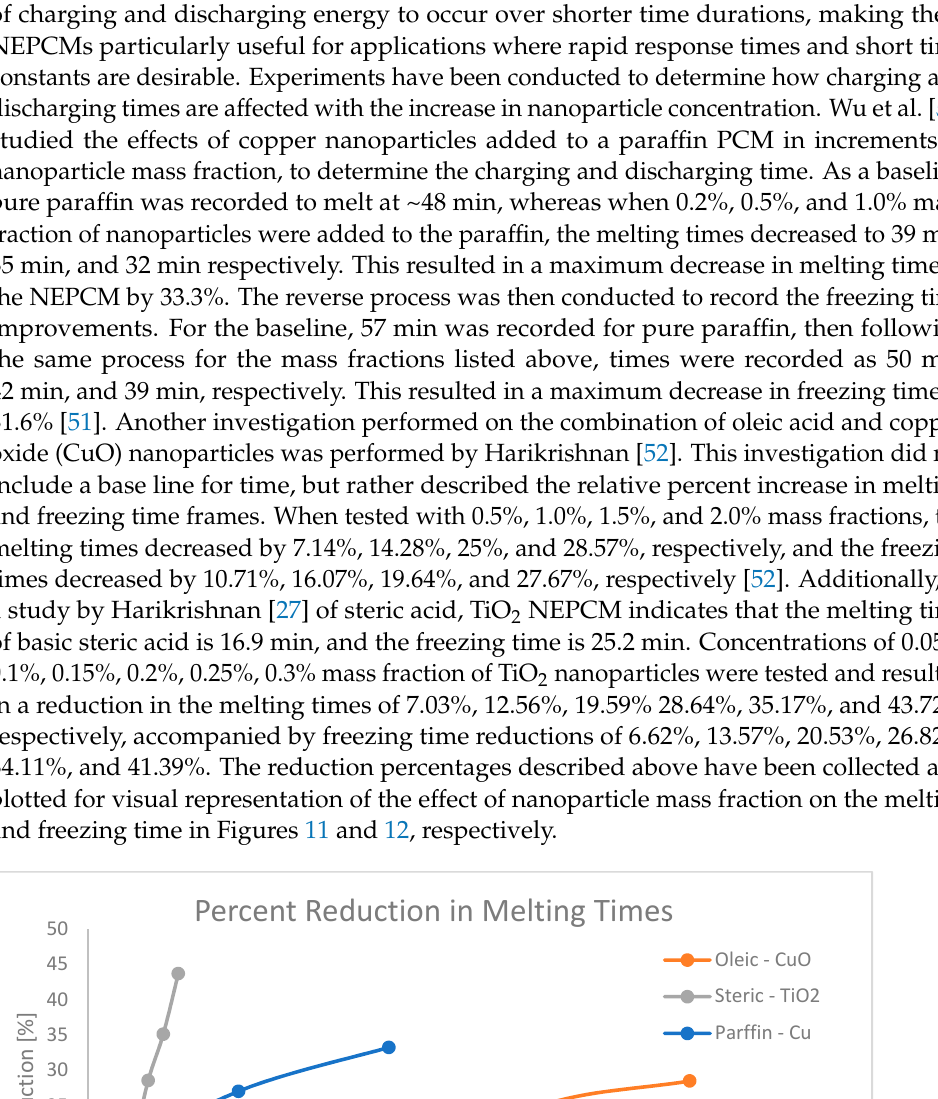
Figure 12. Percent reductions in freezing times of paraffin, oleic and steric acids from references [27,51,52]. From this analysis, the results for most NEPCMs that contain nanoparticles with a higher thermal conductivity than the basic PCM indicates that the incorporation of nano- particles that have a higher thermal conductivity than the PCM, when dispersed into the PCM, results in an overall increase in the thermal conductivity. Thus, the higher the mass fraction of nanoparticles, the more conductive the NEPCM will be. If a material’s thermal conductivity is increased, heat will transfer more easily through the material, making it easier for NEPCMs to change state more uniformly when compared to the base forms. 4.1.3. Latent Heat As mentioned above, if an excess of nanoparticles is used, then significant decreases in latent heat can occur, causing the NEPCM to decrease in effectiveness. The addition of most nanoparticles to a PCM will decrease the latent heat value, thereby reducing the amount of thermal energy that the NEPCM can absorb and release [1–3,10–46,49,50]. Even though thermal conductivity is a major focus of NEPCMs, for most applications, the latent